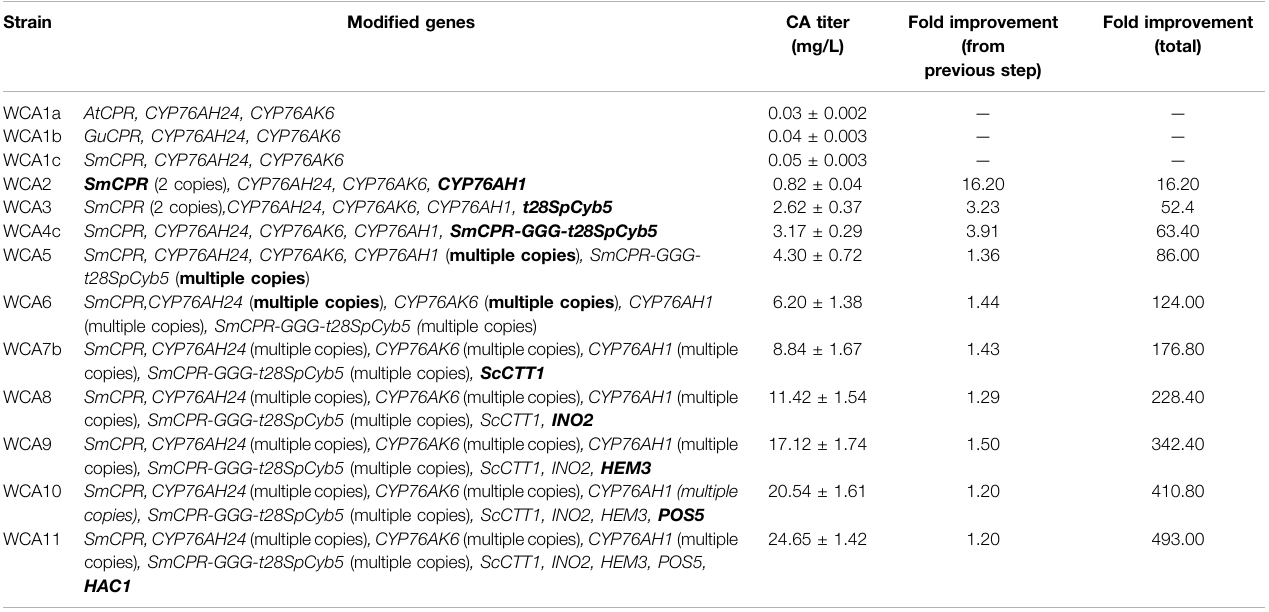
TABLE 2 | Overview of carnosic acid titer improvement.